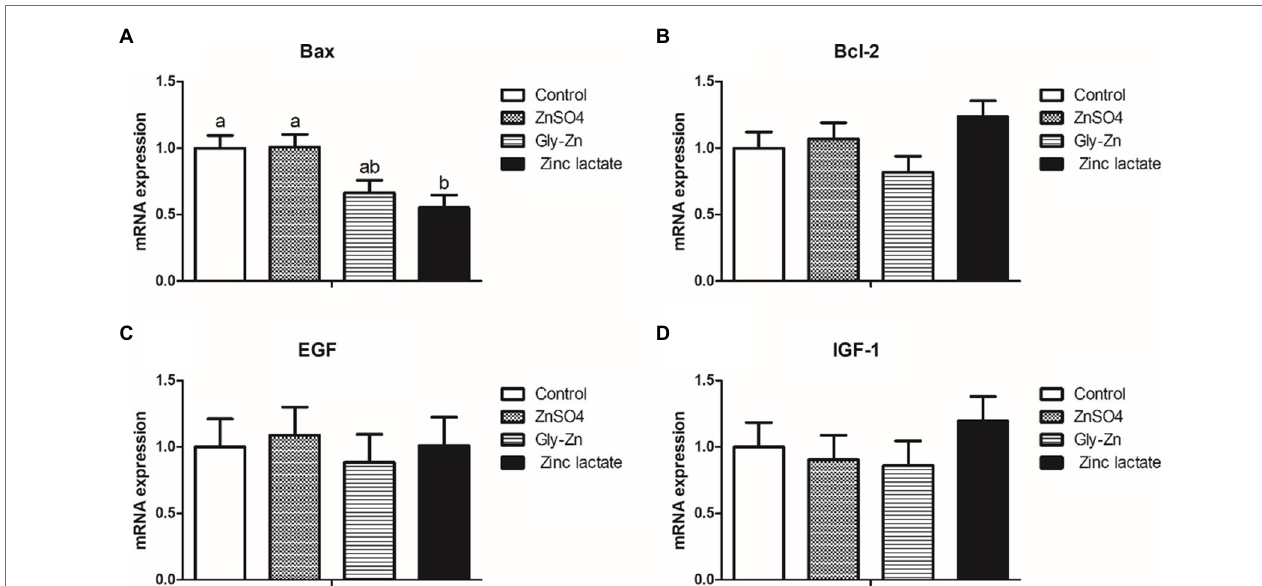
FIGURE 3 | Effect of dietary zinc sources on the relative messenger RNA (mRNA) expression levels of intestinal development-related genes in weaned piglets. Control, basal diet. ZnSO4, basal diet +100 mg/kg zinc sulphate. Gly-Zn, basal diet +100 mg/kg glycine zinc. Zinc lactate, basal diet +100 mg/kg zinc lactate. The relative mRNA expression levels of jejunal Bcl-2-associated X protein (Bax; A) , B-cell lymphoma/leukaemia-2 (Bcl-2; B) , epidermal growth factor (IGF-1; C) , and insulin-like growth factor-1 (IGF-1; D) were determined by real-time quantitative PCR. a,b Within a row, means without a common superscript letter differ ( p <